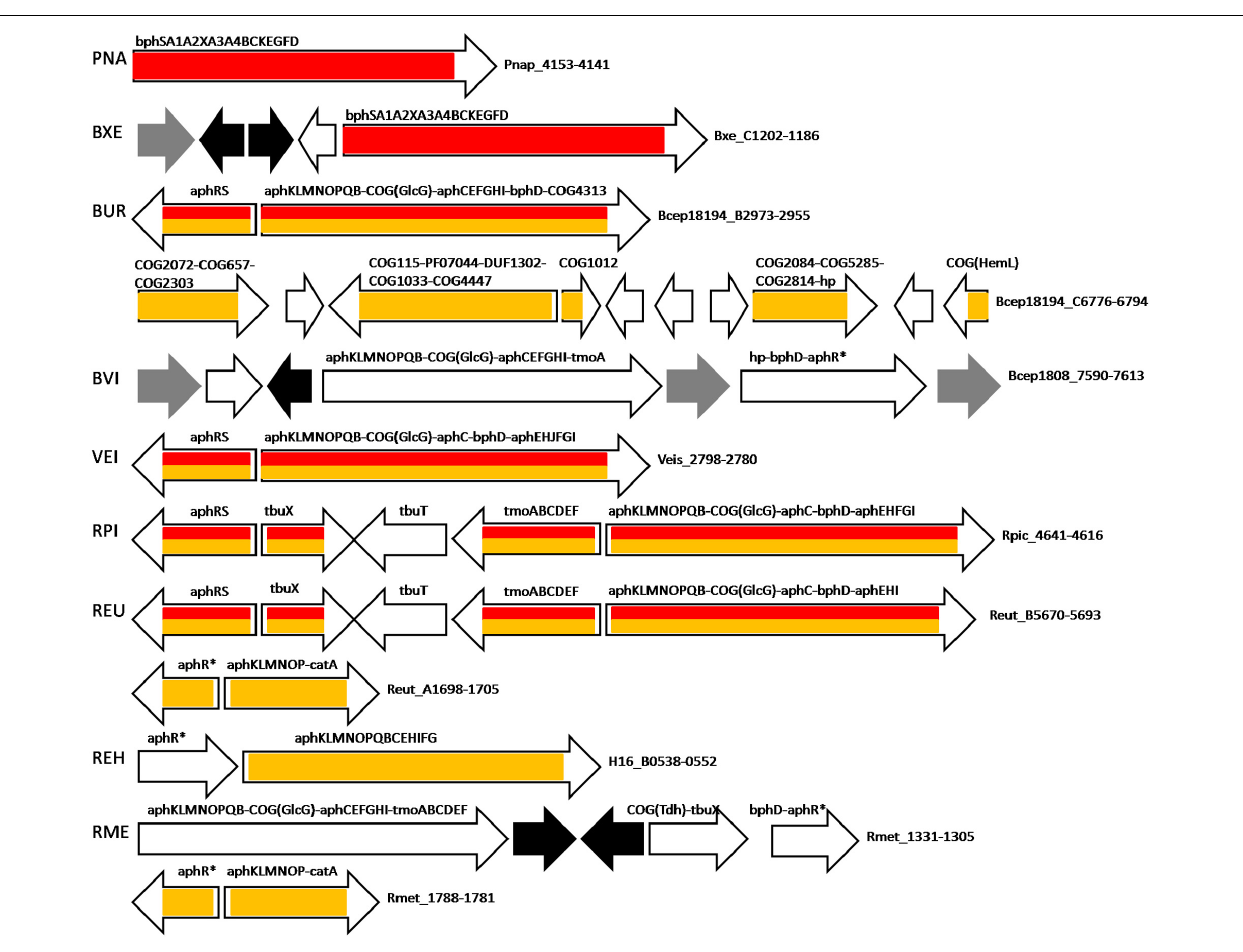
Frontiers in Microbiology |